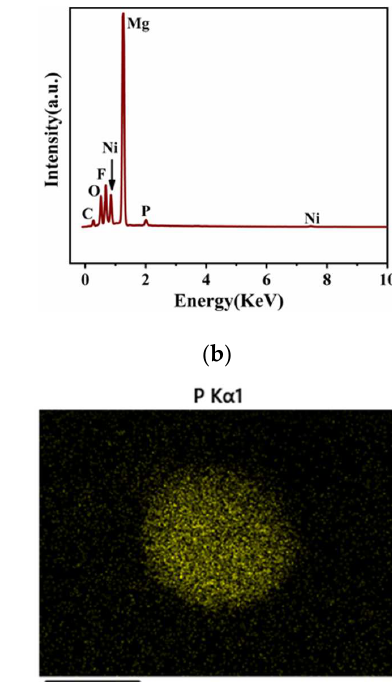
Figure 2. ( a ) XPS survey spectra; ( b ) XPS spectra of Mg 1s core level regions; ( c ) XPS spectra of the O 1s core level regions; ( d ) XPS spectra of F 1s core level regions.